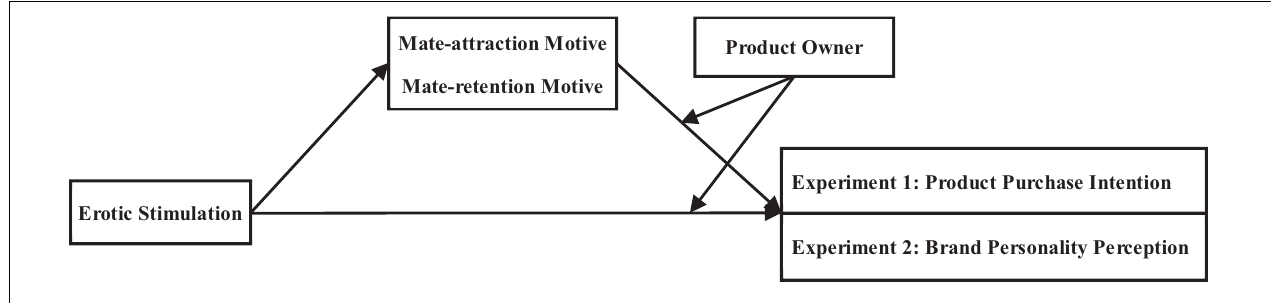
FIGURE 1 | Theoretical